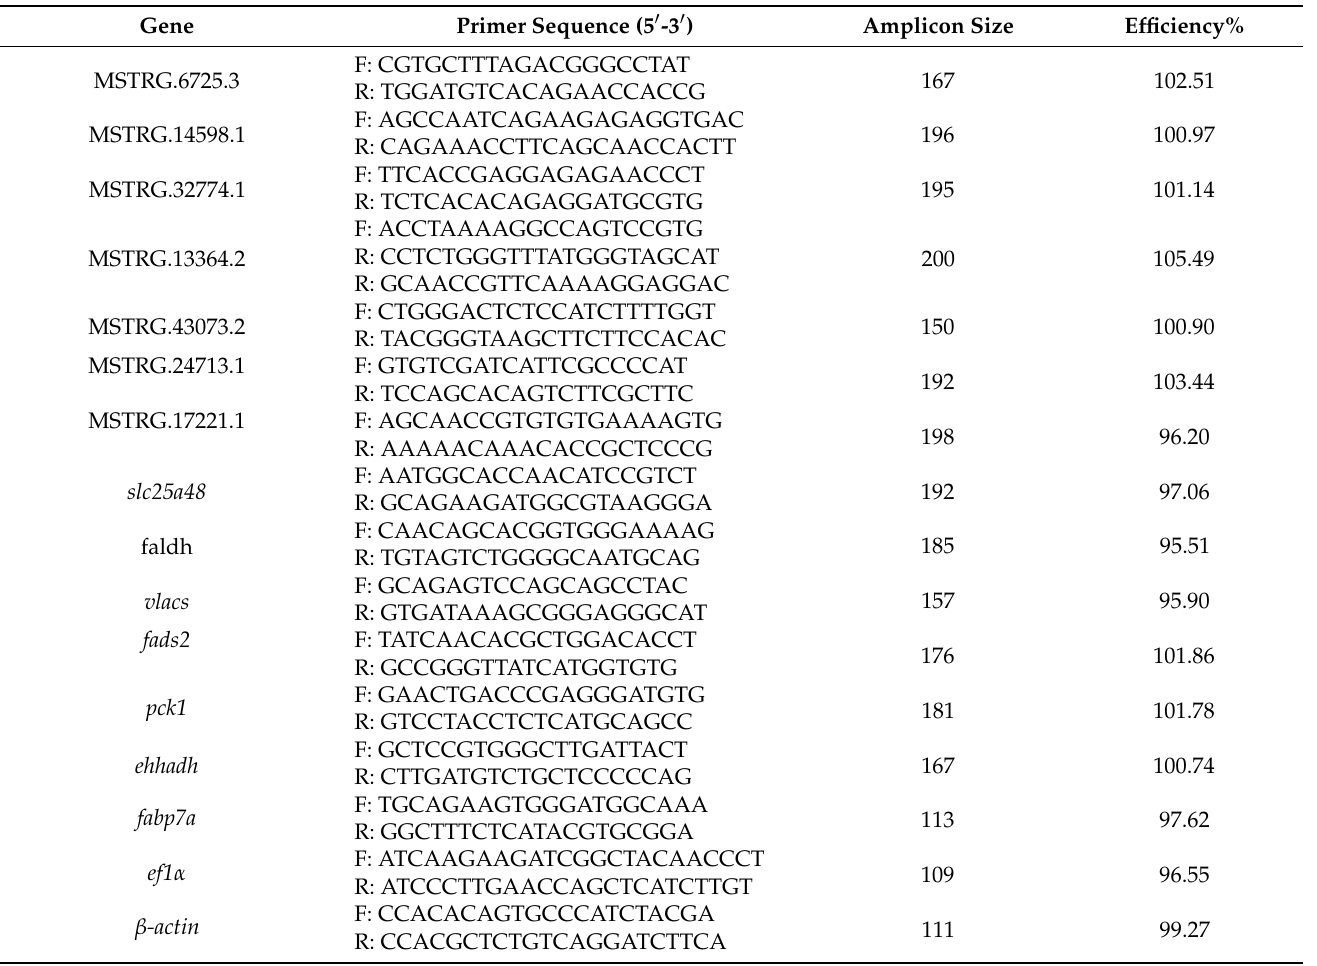
Table 1. Primer sequences used for qRT-PCR of DE-mRNAs and